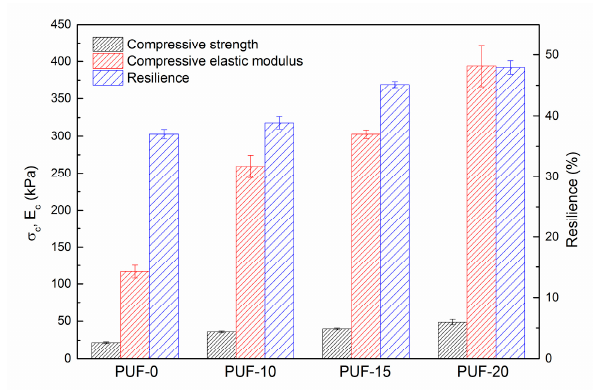
Figure 2. Compressive strength, compressive modulus and resilience values of polyurethane